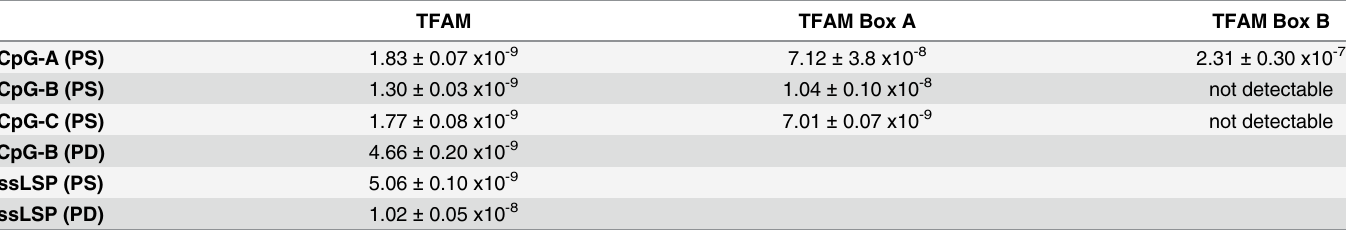
Table 1. Protein/DNA dissociation constants K D